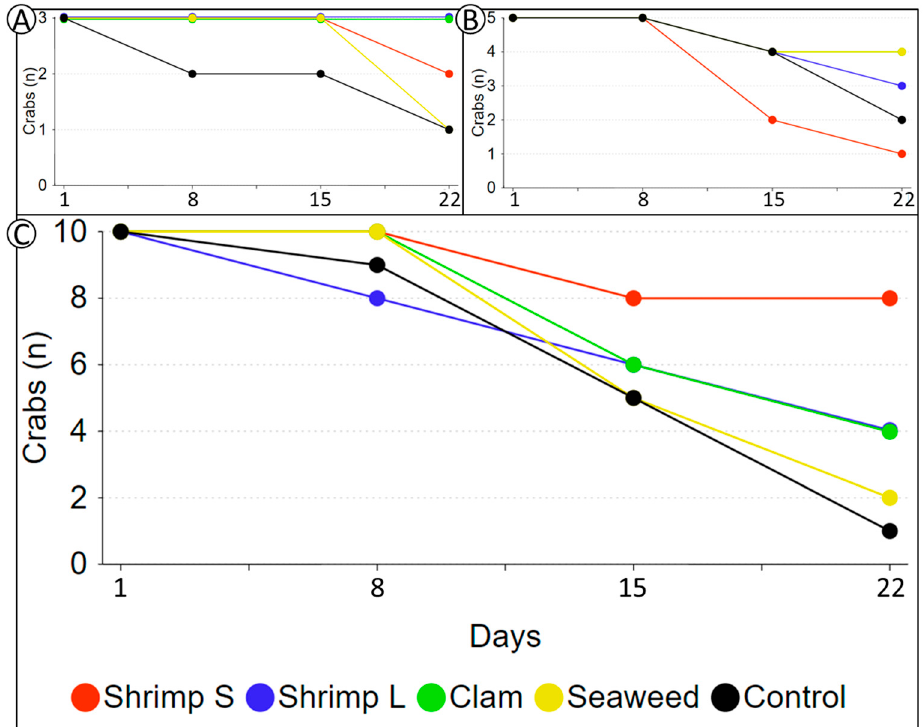
Figure 4. Charybdis feriatus prey experiment. All the prey groups showed higher survival than the control in the high-density groups: ( A ) low density (3 crabs); ( B ) middle density (5 crabs); ( C ) high density (10 crabs).